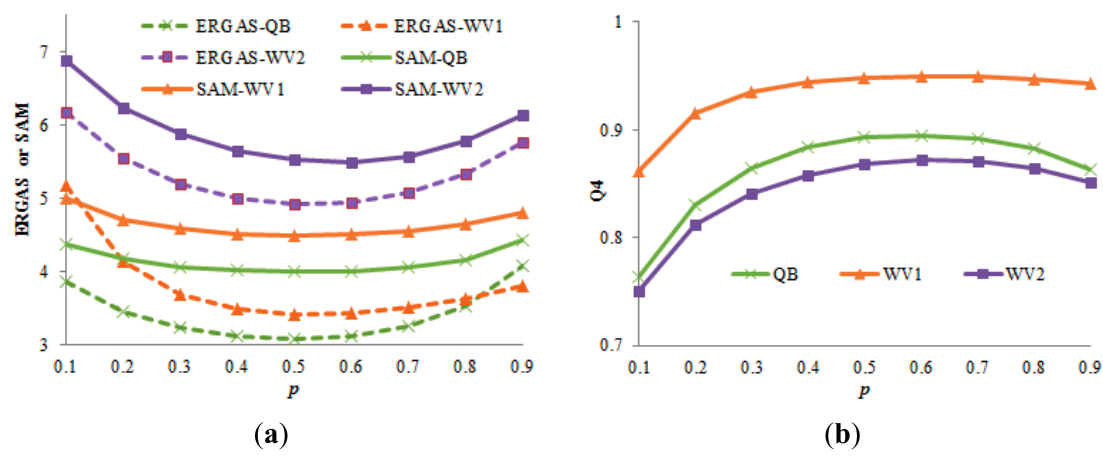
Figure 6. ERGAS, SAM ( a ) and Q4 ( b ) as functions of the s value in the GLP-based methods for all three datasets, including WorldView-2 (WV) and QuickBird